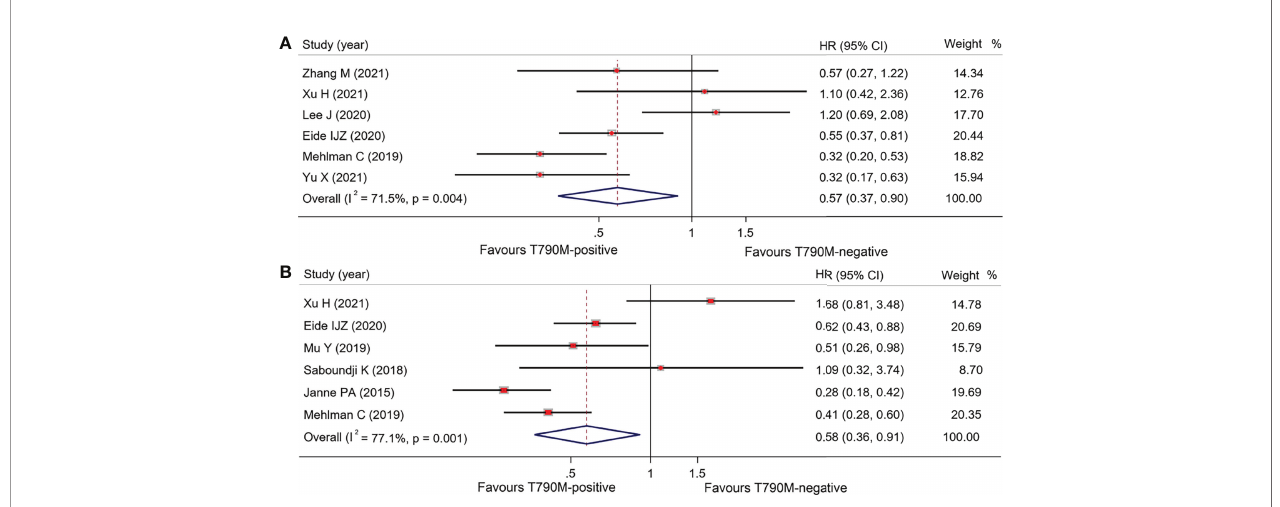
FIGURE 3 | Comparison between T790M-positive and T790M-negative patients of overall group (A) and forest plot of OS (B) , and forest plot of